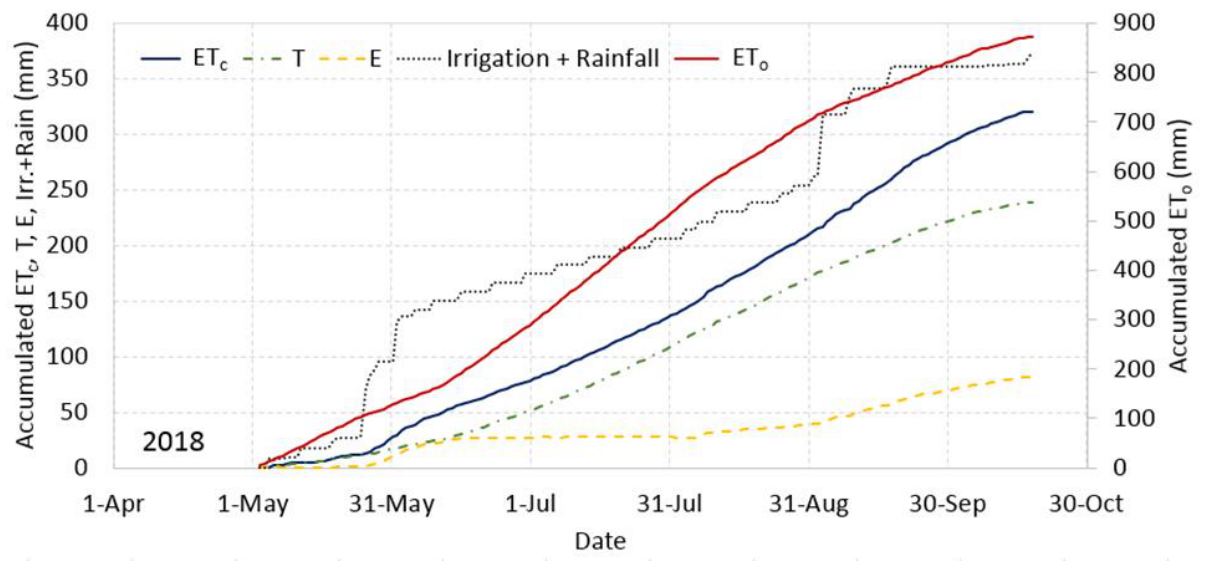
Figure 9. Evolution of accumulated values of modeled ET c , T, and E for the 2018 growing season. Accumulated ET o and irrigation + rainfall are also superposed.